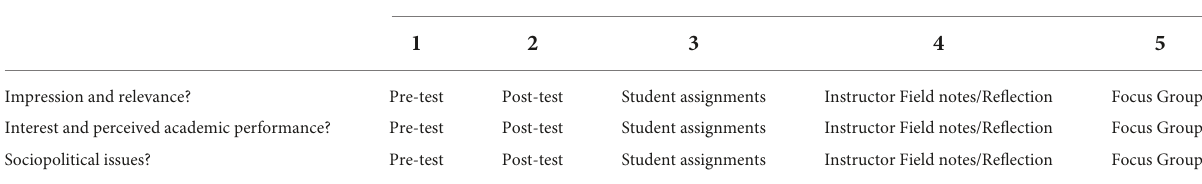
TABLE 1 Triangulation matrix for data